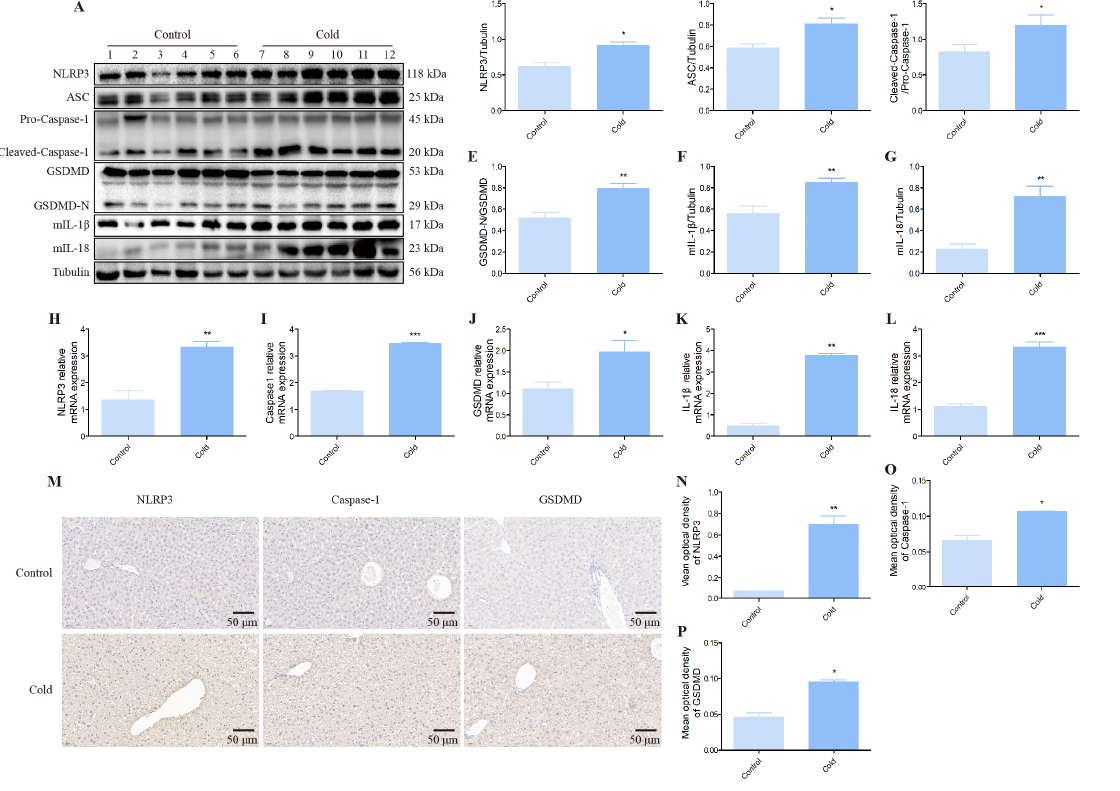
Figure 4. Effect of cold stress on NLRP3/GSDMD pyroptosis pathway assessed by Western blot, qRT-PCR and immunohistochemistry. ( A ) NLRP3, ASC, Caspase-1, GSDMD, IL-1 β , IL-18 and Tubulin protein levels in each group. ( B – G ) Quantification of expression levels based on expression ratios of NLRP3/Tubulin, ASC/Tubulin, Cleaved-Caspase-1/Pro-Caspase-1, GSDMD-N/GSDMD, mIL- 1 β /Tubulin, mIL-18/Tubulin. ( H – L ) The histograms of relative mRNA analysis of NLRP3/ β -actin, Caspase-1/ β -actin, GSDMD/ β -actin, IL-1 β / β -actin, IL-18/ β -actin. ( M ) Immunohistochemical scans of NLRP3, Caspase-1 and GSDMD. (Scale bar = 50 µ m) ( N – P ) Average optical density values of NLRP3, Caspase-1 and GSDMD proteins. Data are presented as mean ± standard ( n = 6). * p < 0.05, ** p < 0.01, *** p <